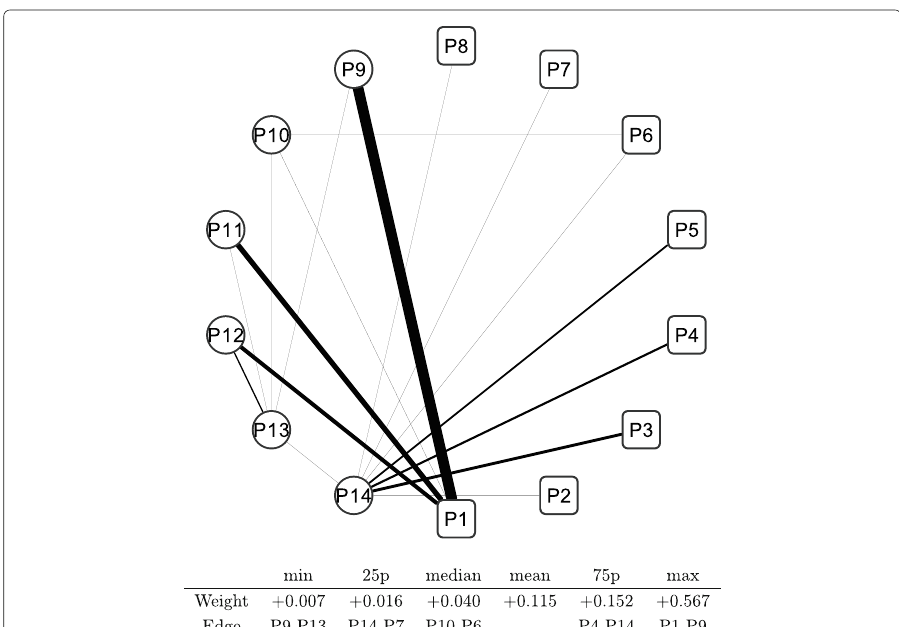
Fig. 14 Changes in network between sub-periods: T2–T3. Note: The network shows the difference between the sub-period T2 and T3. The edge weight (the edge width) is calculated by subtracting elements of the adjacency matrix of T3 from those of T2 described as T2 − T3. Only the edges that have positive weights (T2 > T3) are shown. The bottom table shows the quantiles of edge weights distribution with corresponding edges